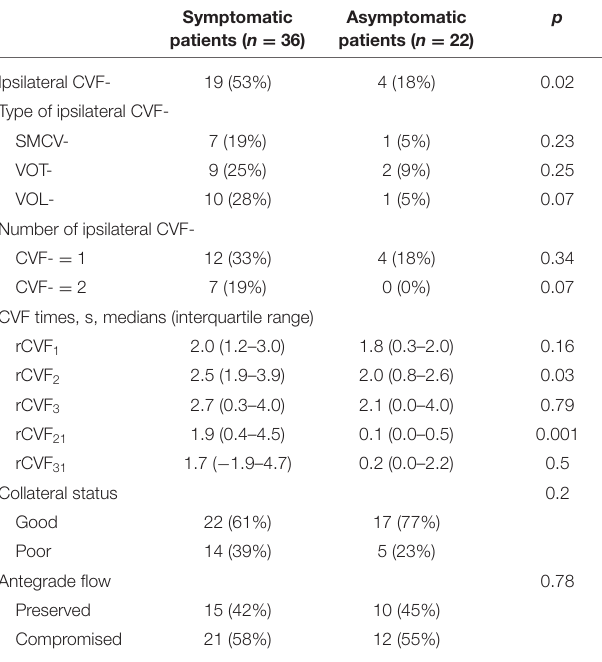
TABLE 3 | Imaging findings in symptomatic and asymptomatic patients.